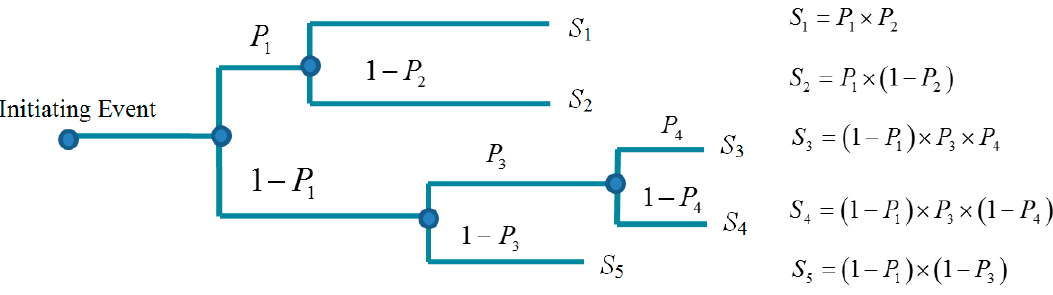
Figure 3. An example of a conventional Event Tree.